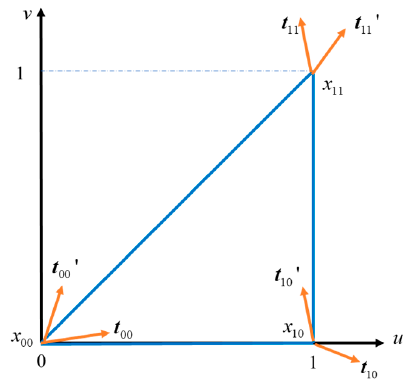
Figure 7. Coordinates and tangent vectors of the vertex of a curved triangle. Substitute the characteristic parameters v = 0, u = 1, and u = v into Equation